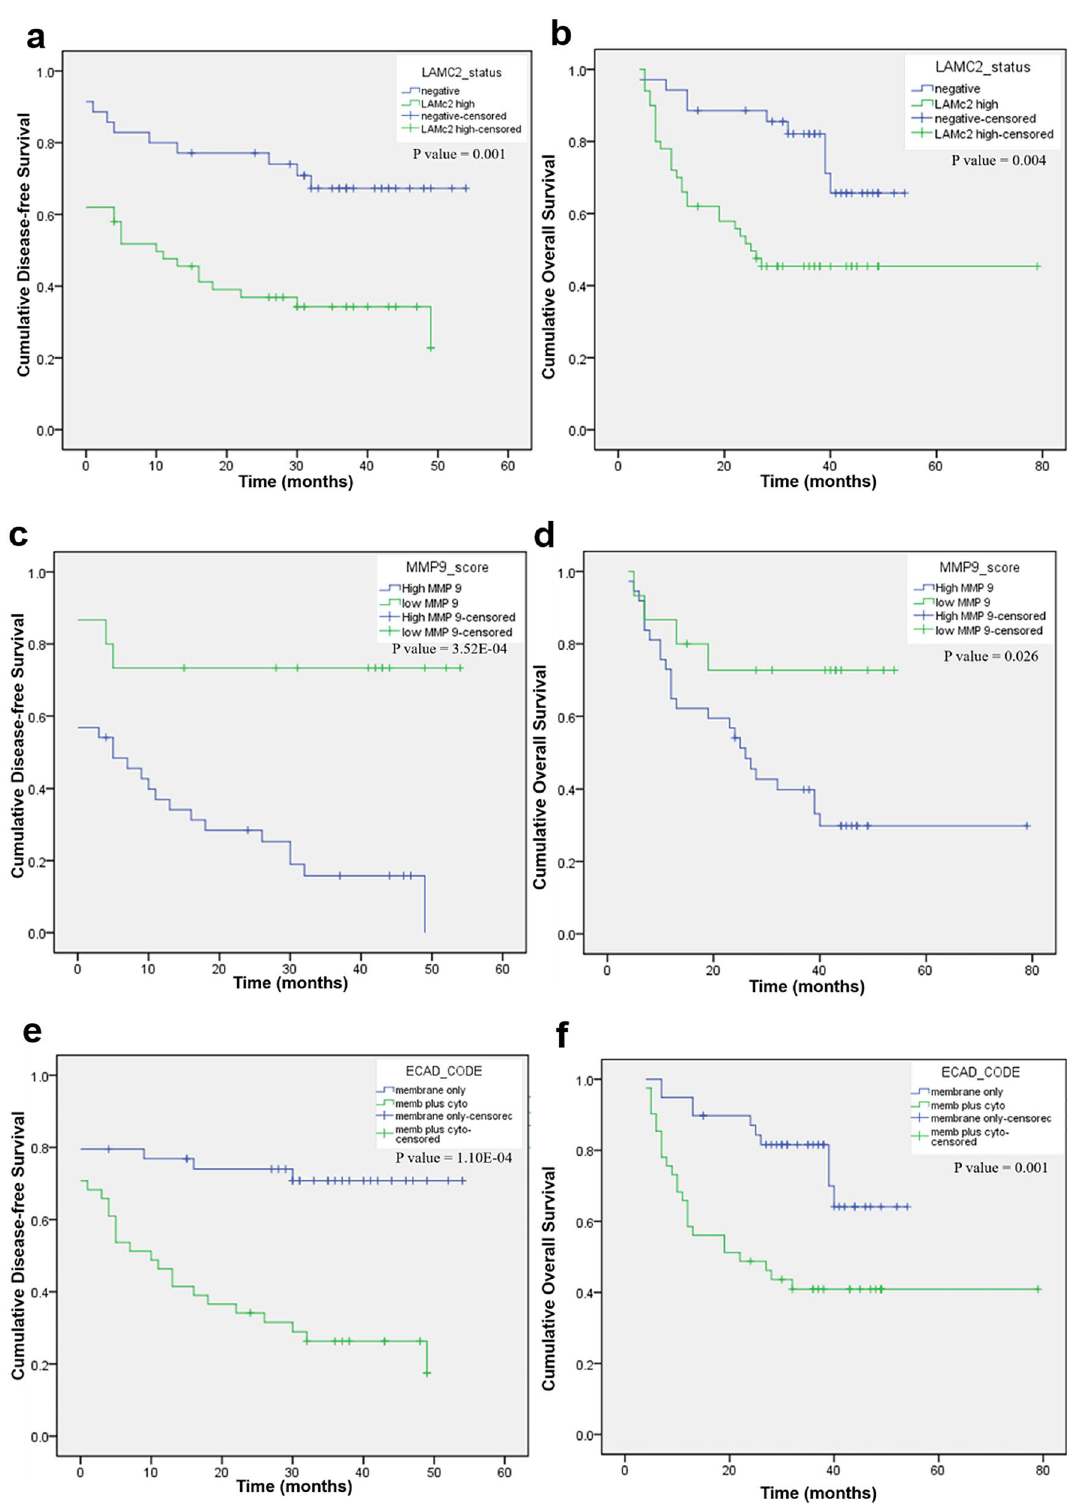
Figure 7. Kaplan–Meier survival analysis of molecular markers in OTSCC patients ( a ). Disease free survival by LAMC2 immunoexpression ( b ). Overall survival by LAMC2 immunoexpression ( c ). Disease free survival by MMP9 immunoexpression ( d ). Overall survival by MMP9 immunoexpression ( e ). Disease free survival by ECAD immunoexpression ( f ). Overall survival ECAD immunoexpression. P values correspond to the log-rank test comparing the survival